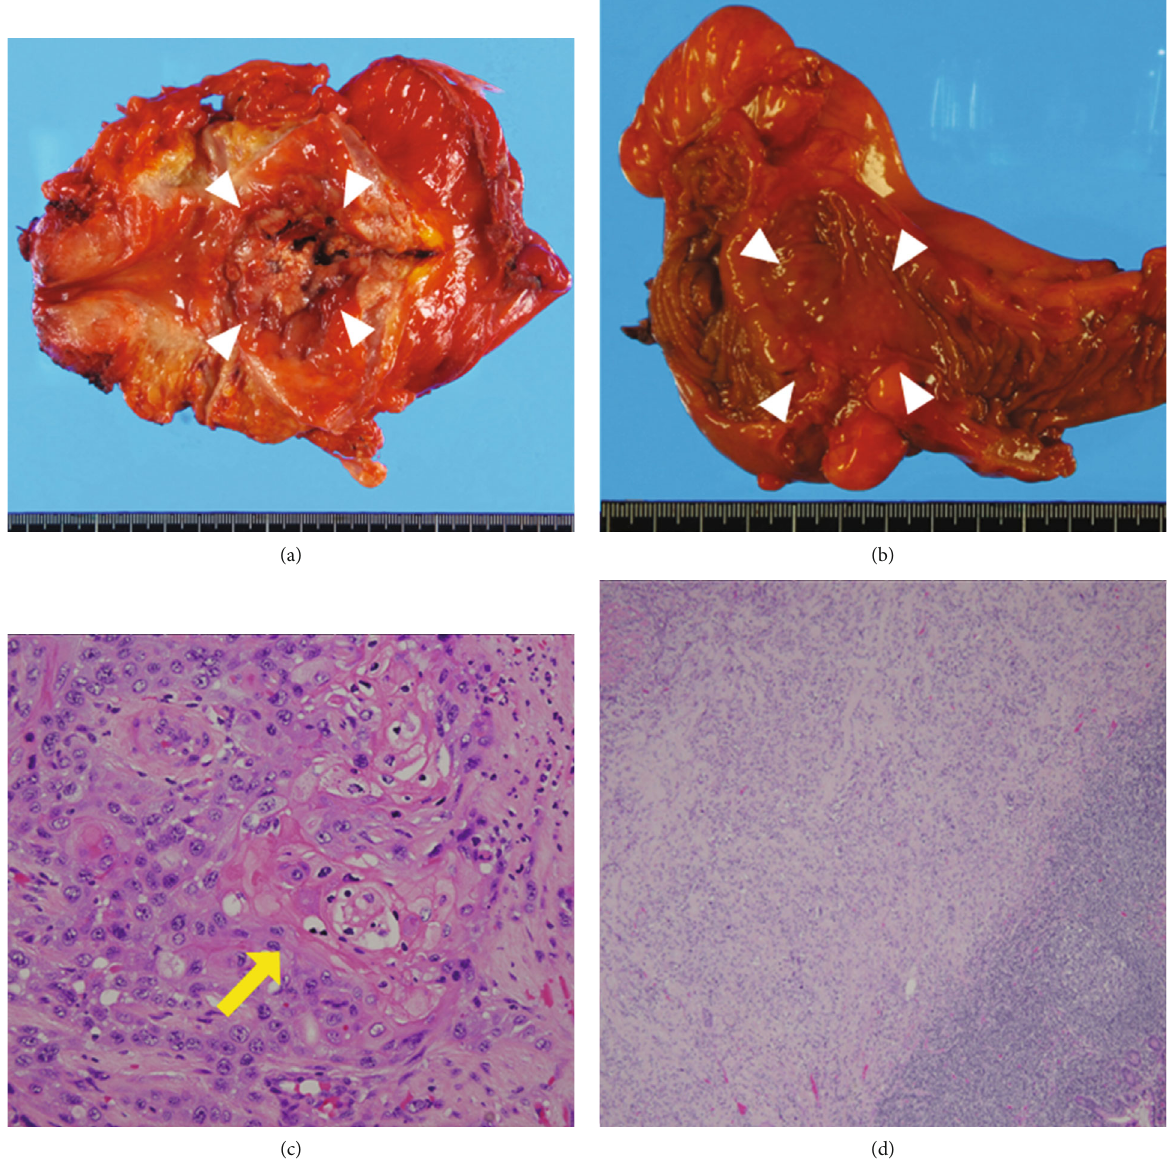
Figure 4: (a) A macroscopic image of the resected bladder. The bladder tumor was a raised lesion with an irregular surface, necrotic tissue, and hemorrhage (white arrowheads). (b) A macroscopic image of the lumen of the ileum separated from the bladder. There were submucosal lesions (white arrowheads), suggesting a submucosal invasion of the bladder cancer at the terminal ileum. (c) The bladder tumor was in fi ltrating high-grade urothelial carcinoma with partial keratinization (arrow, hematoxylin & eosin, × 200). (d) The tumor in the terminal ileum had in fi ltrated the submucosal layer under the normal glandular structures (hematoxylin & eosin, ×